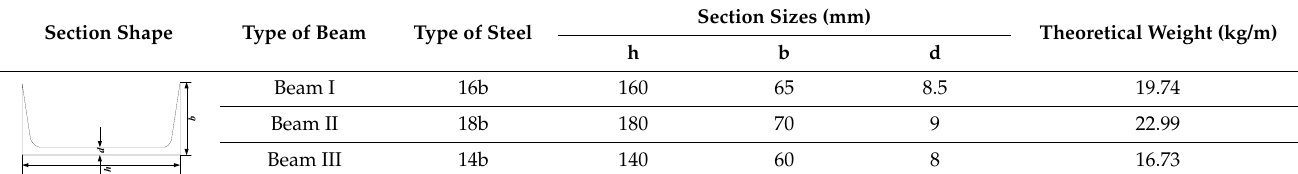
Figure 10. Reinforcement measures on ground surface designed for pylons. Table 4. Section sizes of the steel beams used to reinforce the pylons.